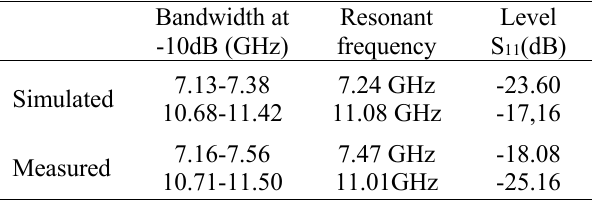
Comparison between measured and simulated values of S 11 .